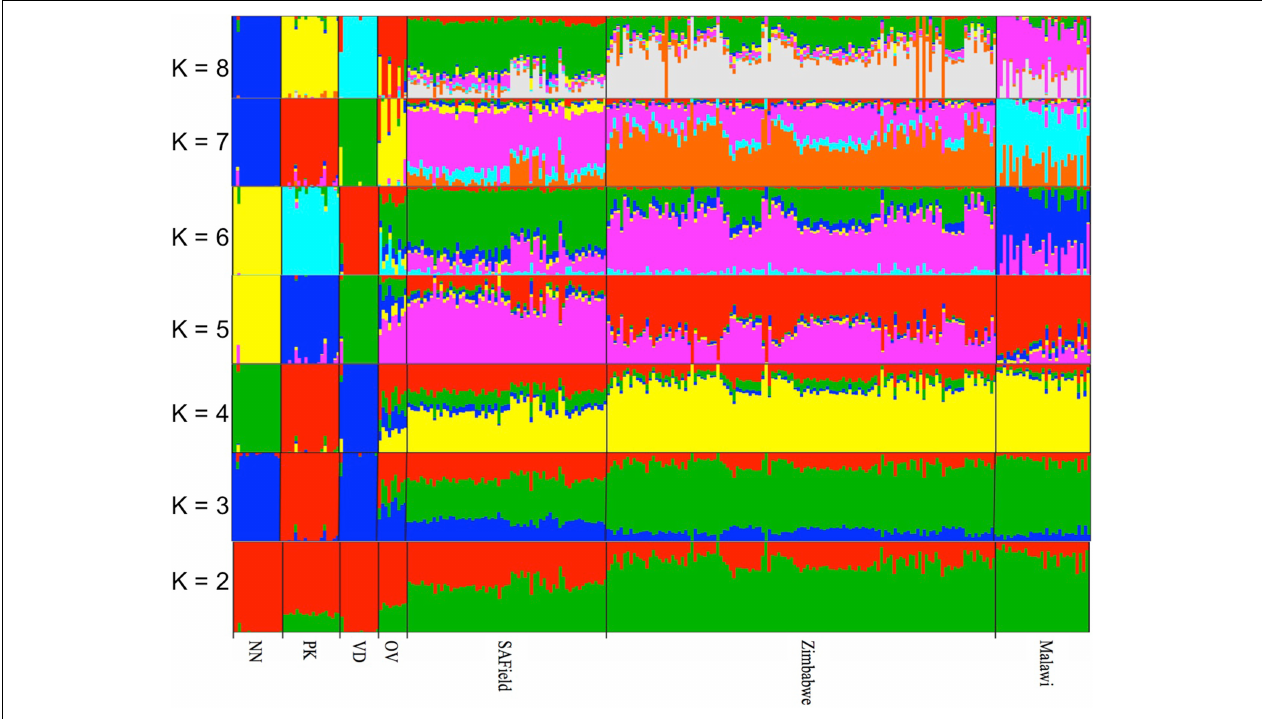
FIGURE 3 | Population substructuring using ADMIXTURE. VD, Venda conservation flocks; NN, Naked Neck conservation flocks; OV, Ovambo conservation flocks; PK, Potchefstroom Koekoek